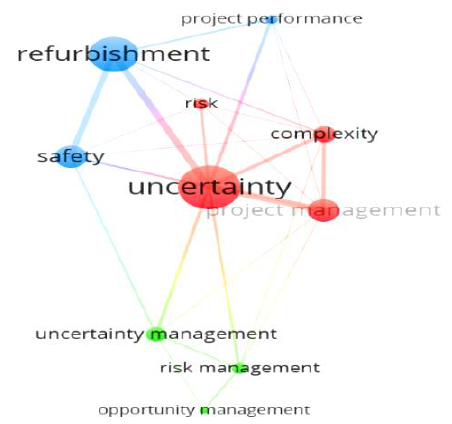
Figure 4. Mapping the co-occurrence of author keywords.